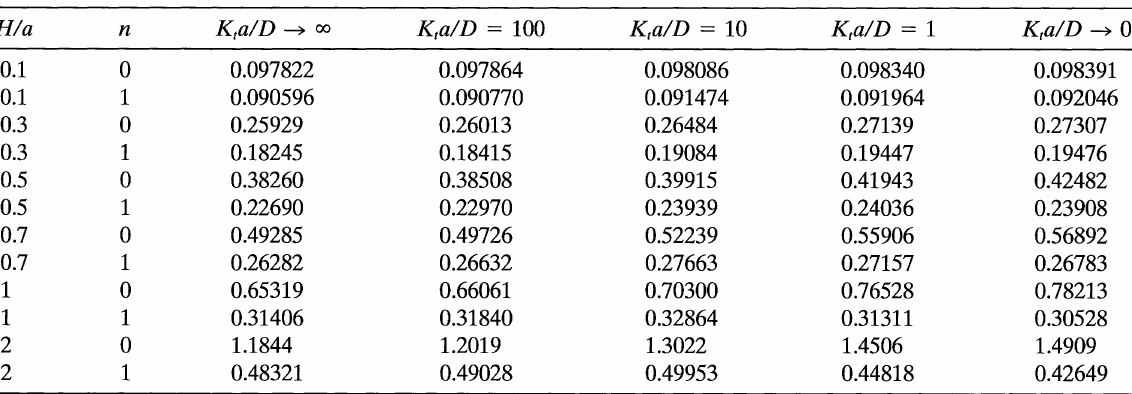
Table 3. NA VMI Factors for Supported Circular Plates with Elastic Moment Edge Constraint, Axisymmetric Modes (m = 0), and v =